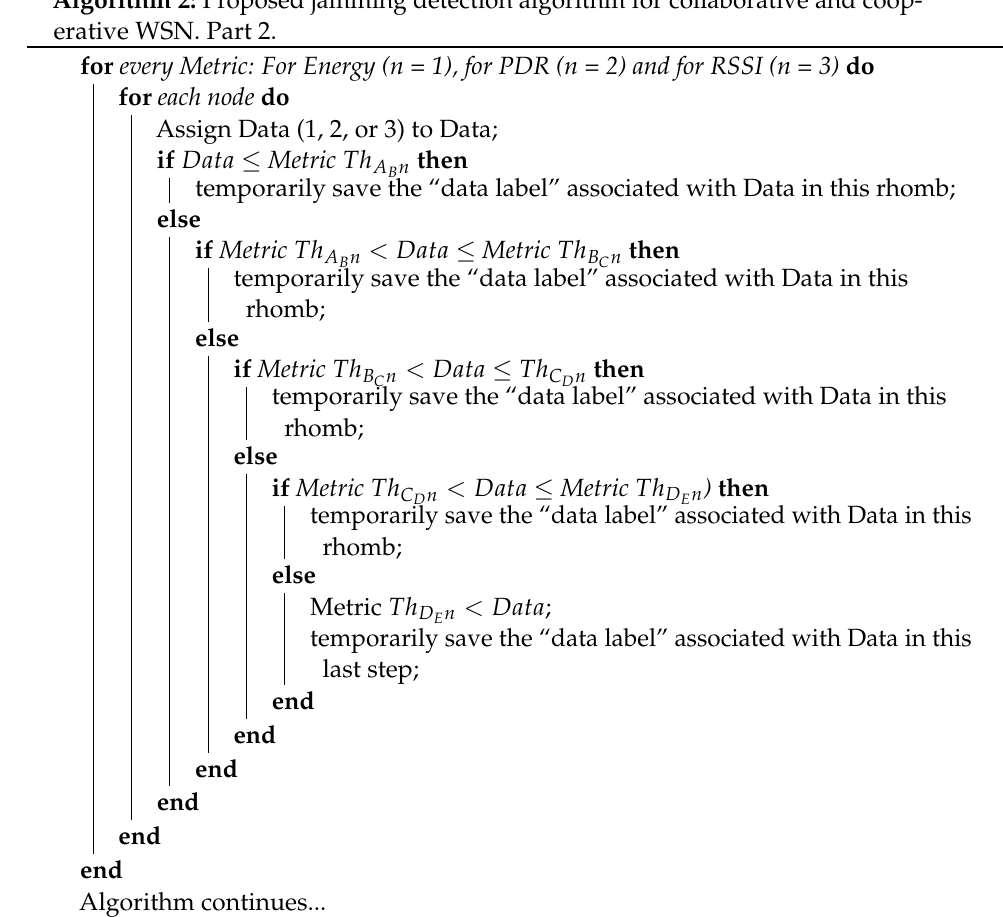
Algorithm 2: Proposed jamming detection algorithm for collaborative and coop- erative WSN. Part 2.